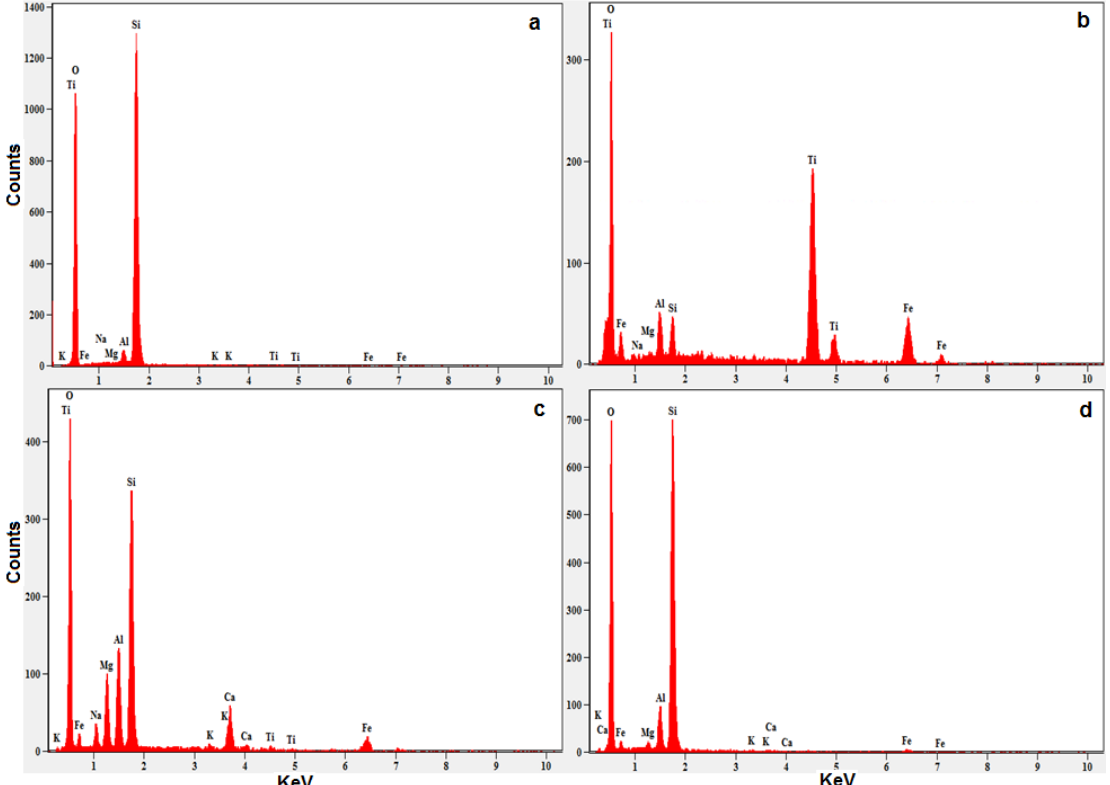
Figure 8. EDX spectra of ( a ) fine silica sand, ( b ) coarse silica sand, ( c ) river sand and ( d ) M sand.